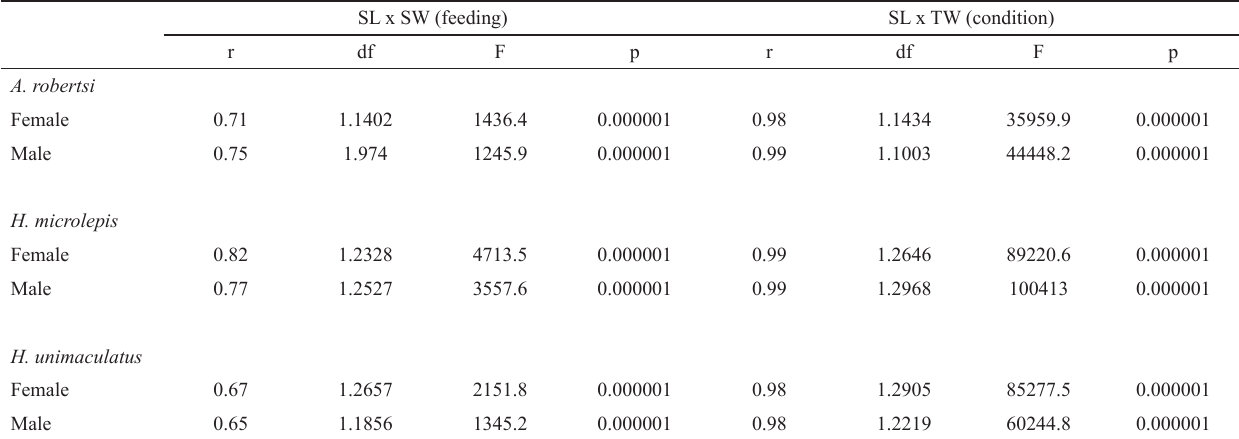
Table 1. Results of linear regressions between standard length (SL, cm) and stomach weight (SW, g) and total weight (TW, g, discounting gonad weight), conducted separately by species and sex. Standard residuals from each regression were used as a measure of feeding activity (SL x SW) and body condition (SL x